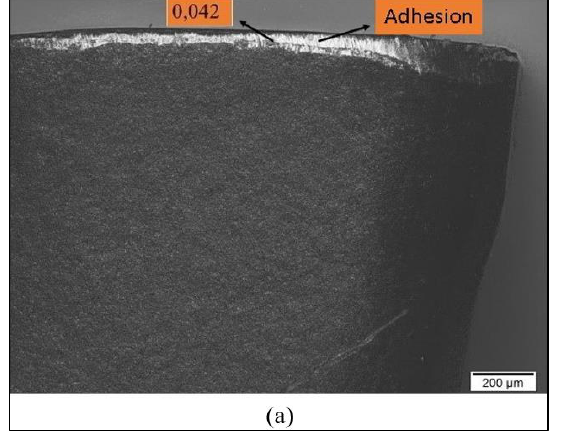
Figure 6a: Wear on the secondary flank with insert 0,4 mm: (a) Without